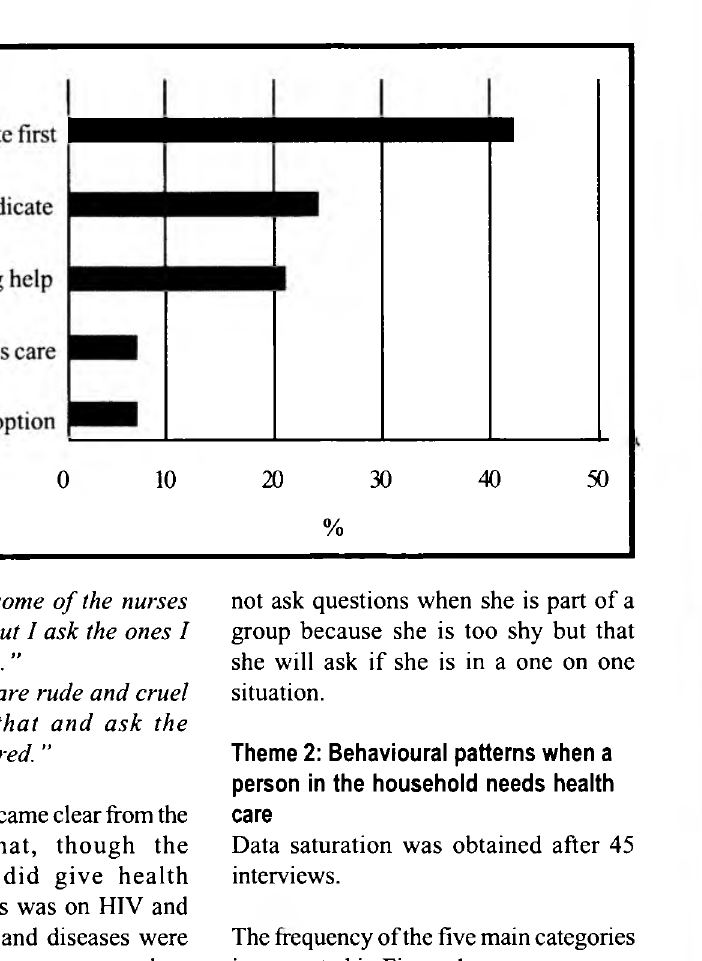
Figure 1: Behavioural patterns when a person in the household needs health